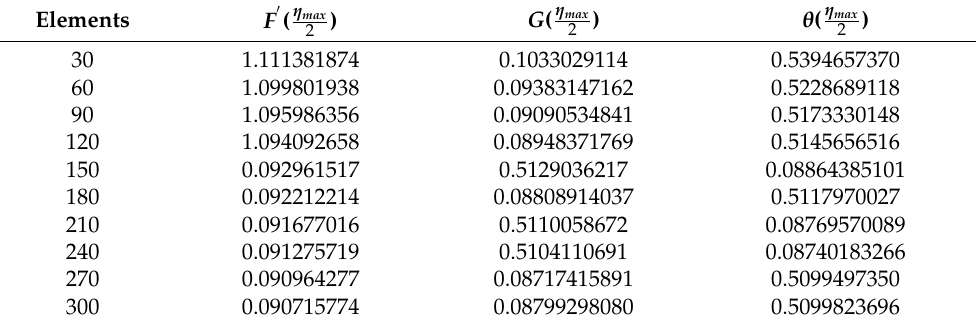
Mesh-free investigation of temperature and velocities within 300 elements when m = 0.3, We = 3, Ω = 2.0, M 2 = 0.3, β e = 0.5, β i = 0.7, (cid:101) = 0.01, F r = 2.5, Pr = 204, Ec = 0.34,